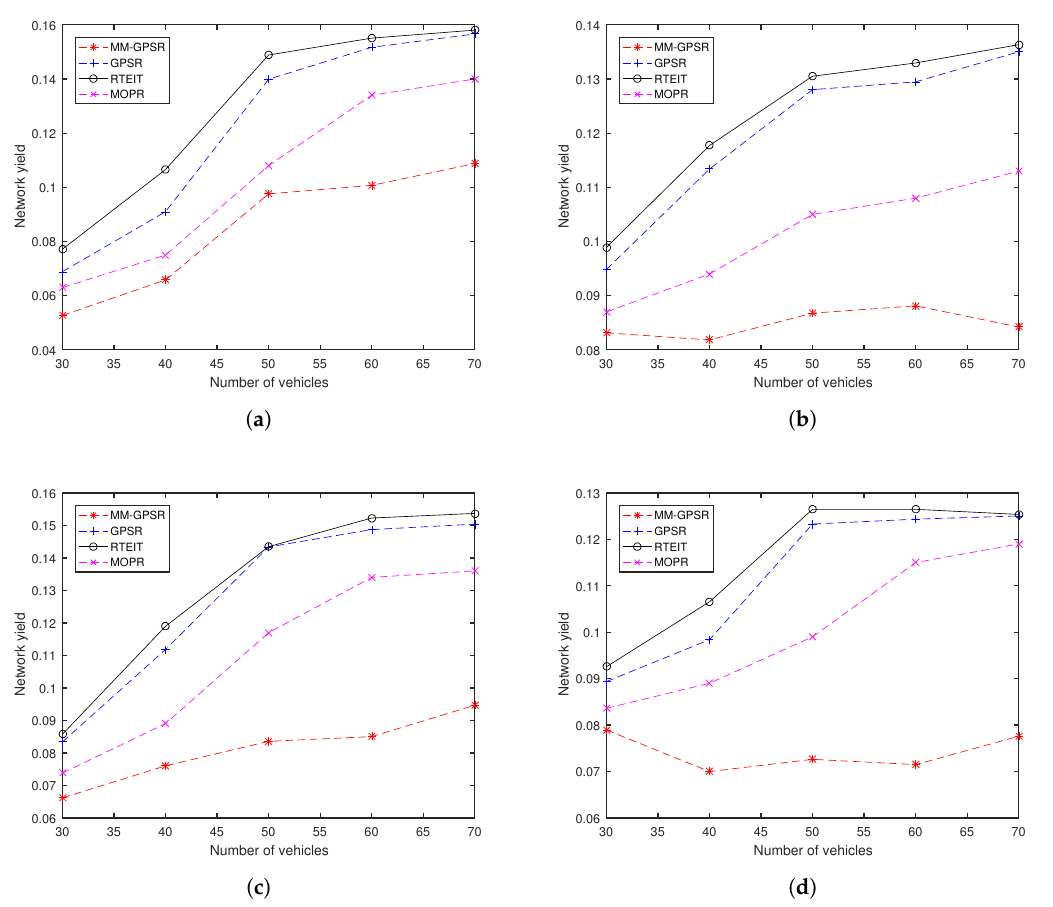
Figure 12. Network Yield for varying the number of vehicles and CBR connections: ( a ) 5 CBR connections; ( b ) 10 CBR connections; ( c ) 15 CBR connections; ( d ) 20 CBR